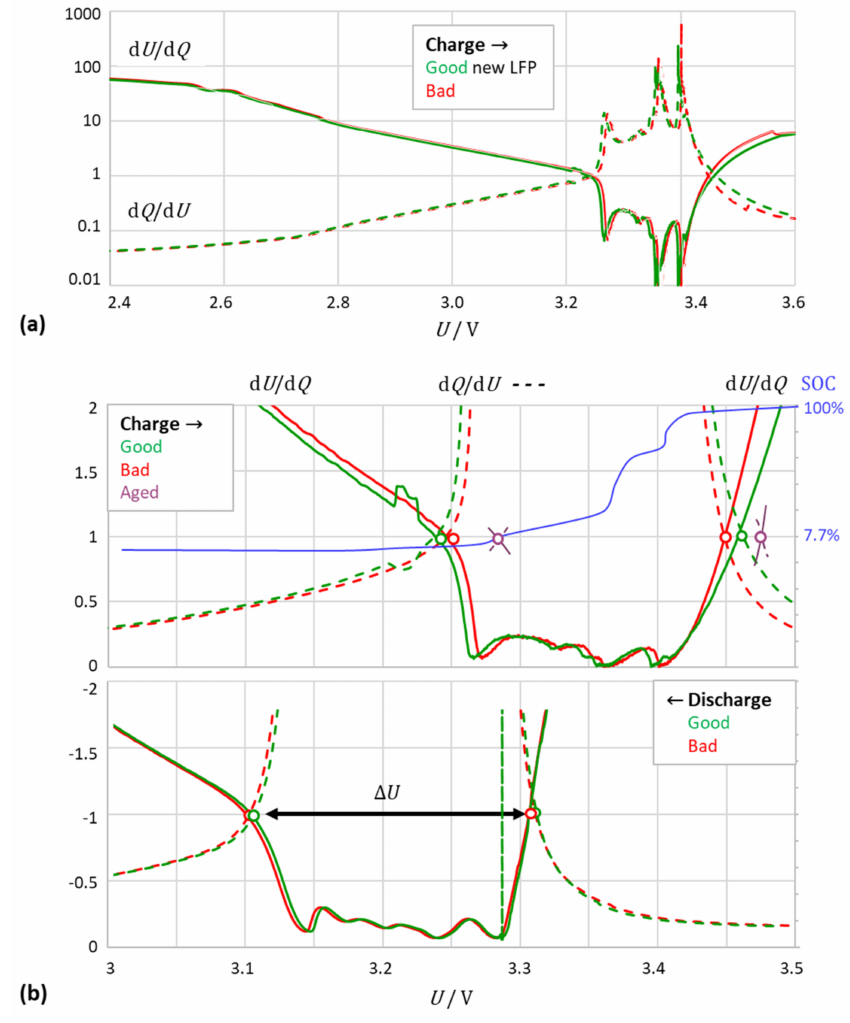
Figure 2. LFP batteries of the same type (LithiumWerks). ( a ) First derivative of the charge curve on the logarithmic scale: the best and the worst battery of 100 samples. ( b ) The intersection points ( ◦ ) of differential capacity d Q /d U (“IC” in Ah V − 1 ) and “incremental voltage” d U /d Q (“DV” in V Ah − 1 ) define the voltage window ∆ U between almost full charge and almost full discharge. The cross × indicates the intersection criterium of a battery after long-term aging (900 cycles, DOD 20, 0.3 A). Quantitative data see